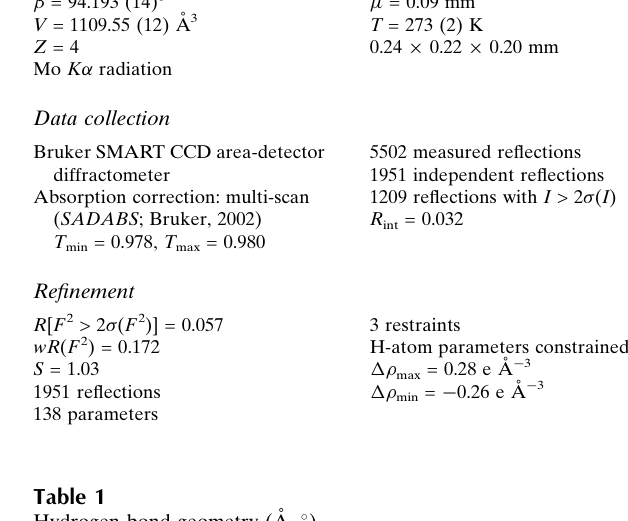
Hydrogen-bond geometry (A˚ , (cid:1)